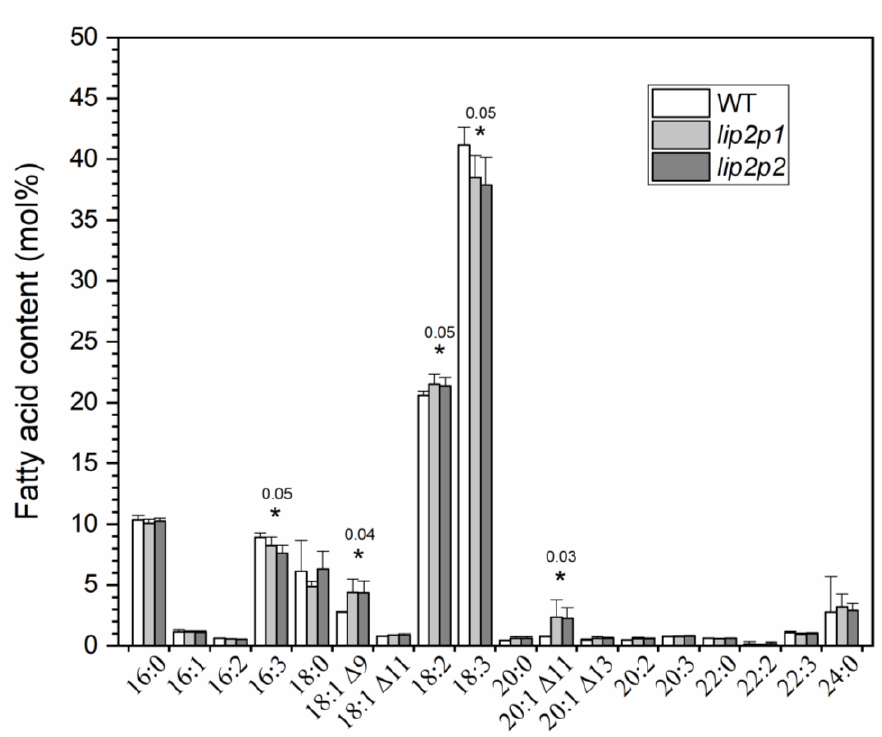
Figure 2. Fatty acid composition of seedlings from control (WT) and octanoyltransferase mutants ( lip2p1 and lip2p2 ) lines. The data correspond to the mean ± SD of three independent measurements. * At the 0.05 level, data are significantly different (showing p values). 16:0, palmitic acid; 16:1,